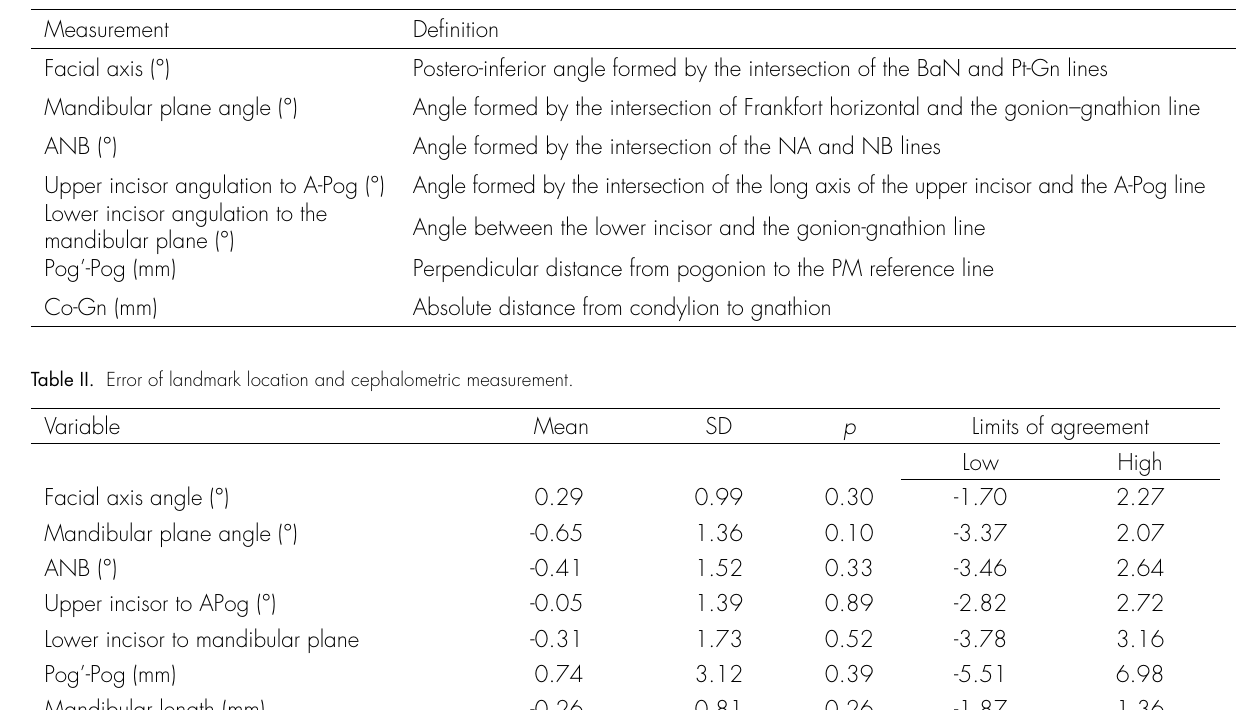
Paired t- test * p ≤